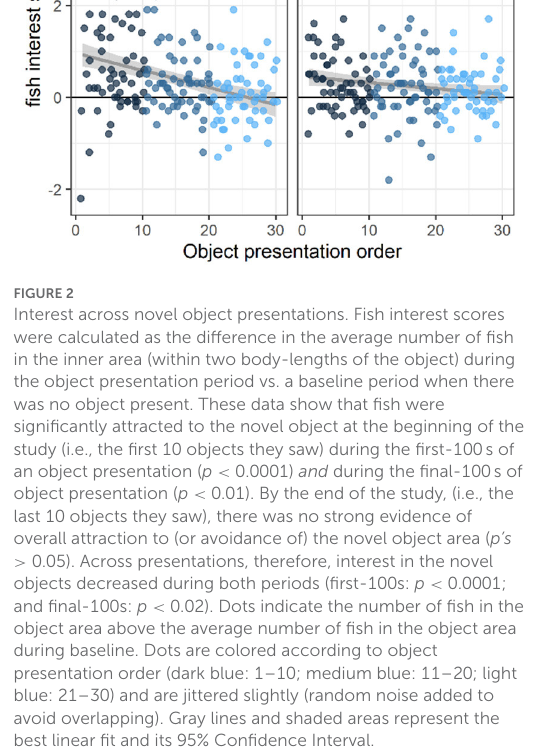
Figure 4]. Tank ID accounted for 21% of the variability in interest [Likelihood Ratio Test: χ 2(1) = 15.30, p